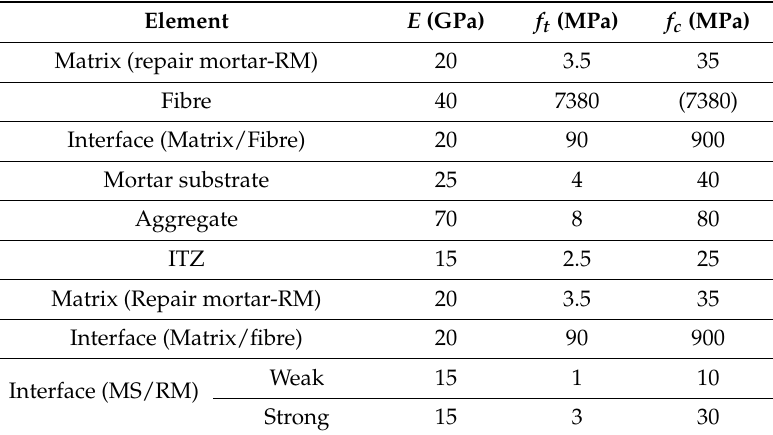
Table 2. Input values for lattice fracture model [27], E stands for the modulus of elasticity, f t stands for the tensile strength and f c for the compressive strength of lattice elements.